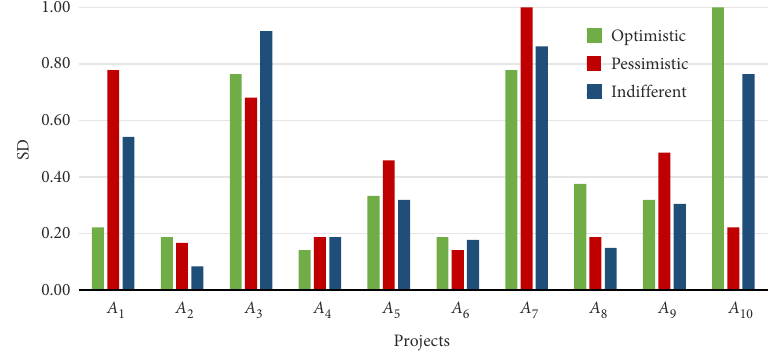
Figure 4. Rankings of projects under experts’ different